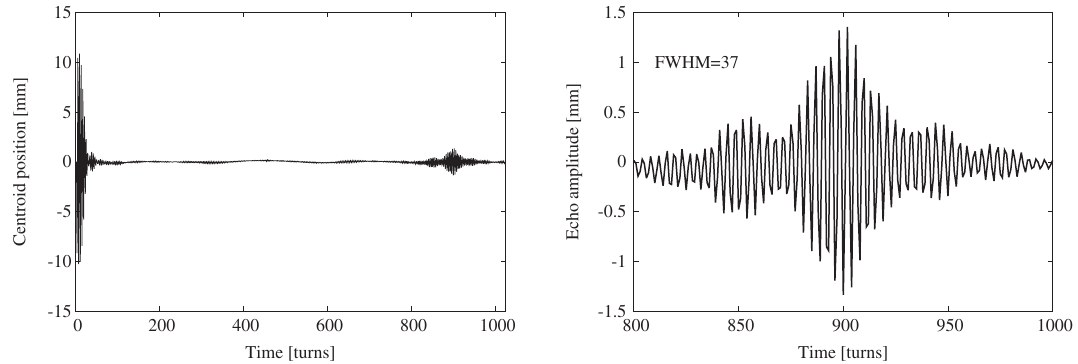
FIG. 5. The entire centroid position turn by turn (left) and the echo pulse isolated (right) for the data with the shortest FWHM. Here the centroid decoheres cleanly after the dipole kick. The quadrupole kick was applied at turn